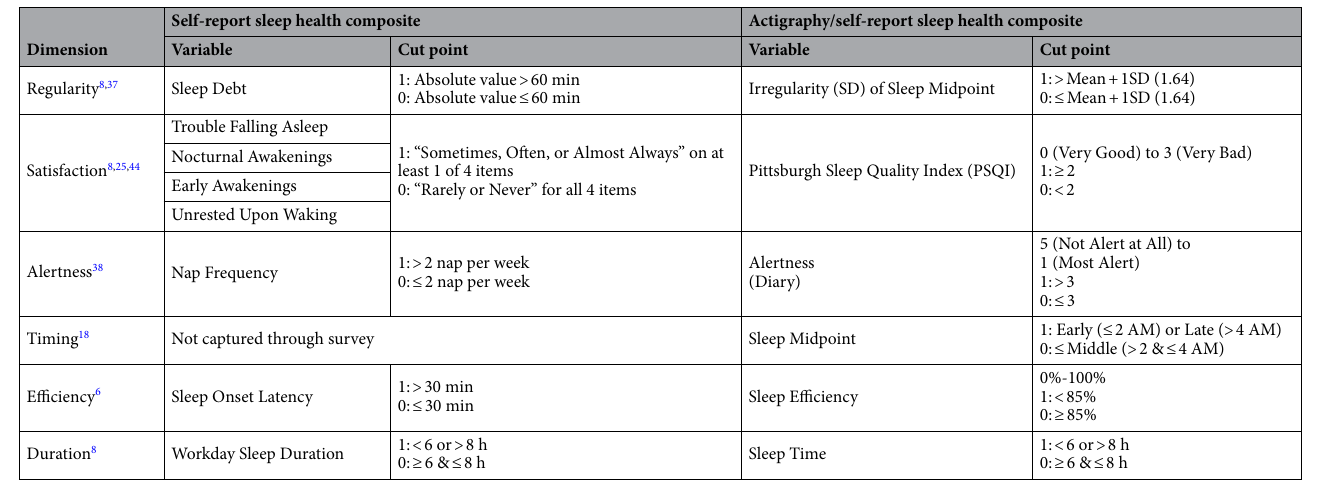
Table 3. Cut points used to construct unweighted sleep health composites. Cut points were determined using empirical evidence from previous research. The satisfaction dimension was assessed by four items related to insomnia symptoms and feeling unrested upon waking, which were highly loaded to sleep quality factor in the Sleep Health Index developed by the National Sleep Foundation 25 . Binary indicators were summed, so that possible scores ranged from 0–5 for the self-report sleep health composite and 0–6 for the actigraphy/self- report sleep health composite. Higher numbers indicated more sleep health